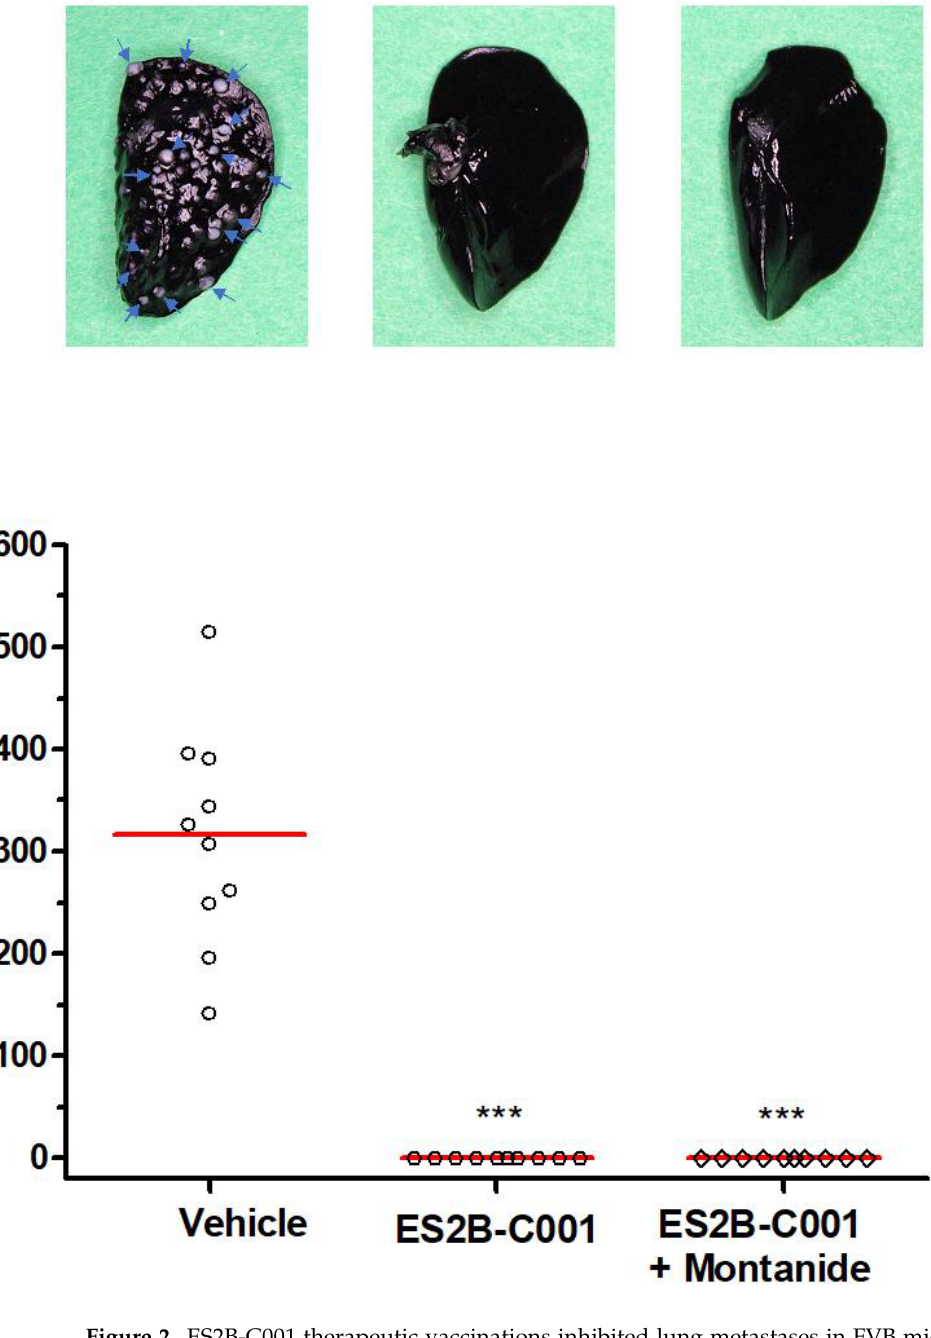
Figure 2. ES2B-C001 therapeutic vaccinations inhibited lung metastases in FVB mice challenged intravenously with QD cells. Lungs were perfused with black India ink to contrast metastatic nodules; pictures show one representative left lung with blue arrows indicating some metastatic nodules (to the left: vehicle; in the middle: ES2B-C001; to the right: ES2B-C001+Montanide). In the graph, each point represents the total number of lung nodules of one mouse, as counted under a dissection microscope; *** p < 0.001 vs. vehicle by the Dunn’s non-parametric test. Serum anti-HER-2 Ig of FVB mice plateaued in the 1–10 mg/mL range, and antibody levels persisted in this range for many months after the last vaccination (Figure 3), indicating that vaccinations elicited long-term immunological memory against HER-2. ES2B-C001 elicited all subclasses of IgG, including those endowed with the strongest anti-tumor activity, i.e., IgG2a, IgG2b and IgG3 (Figure